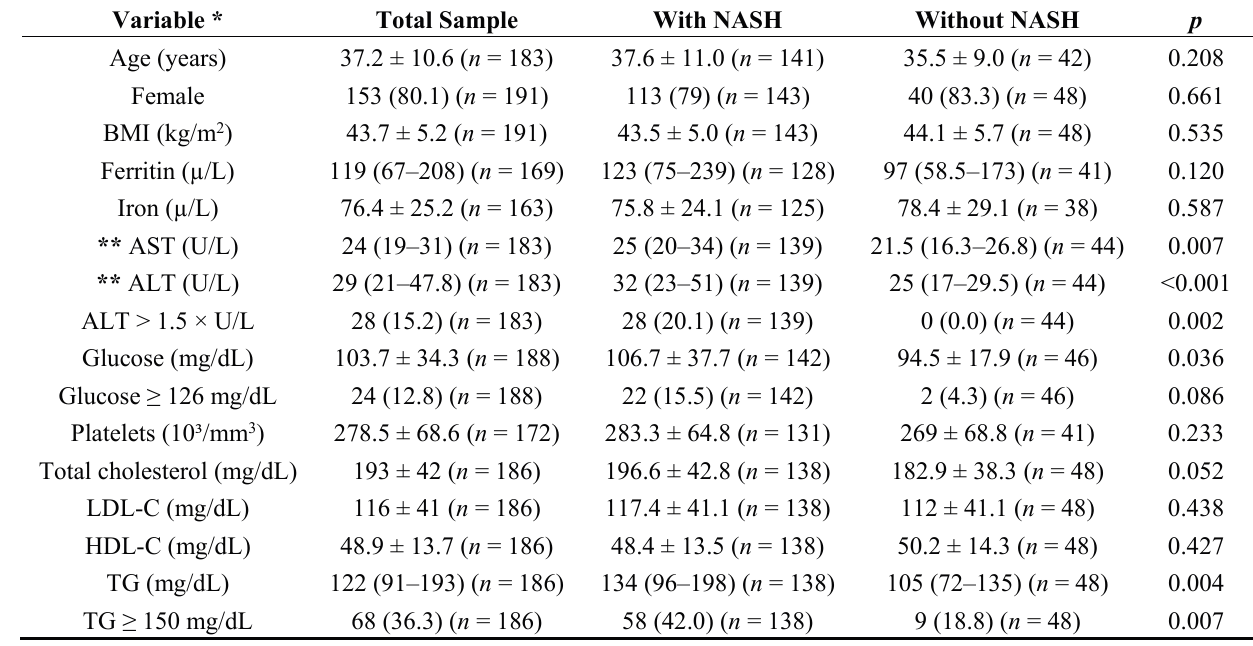
Table 1. Bivariate analysis according to the presence of non-alcoholic steatohepatitis (NASH).